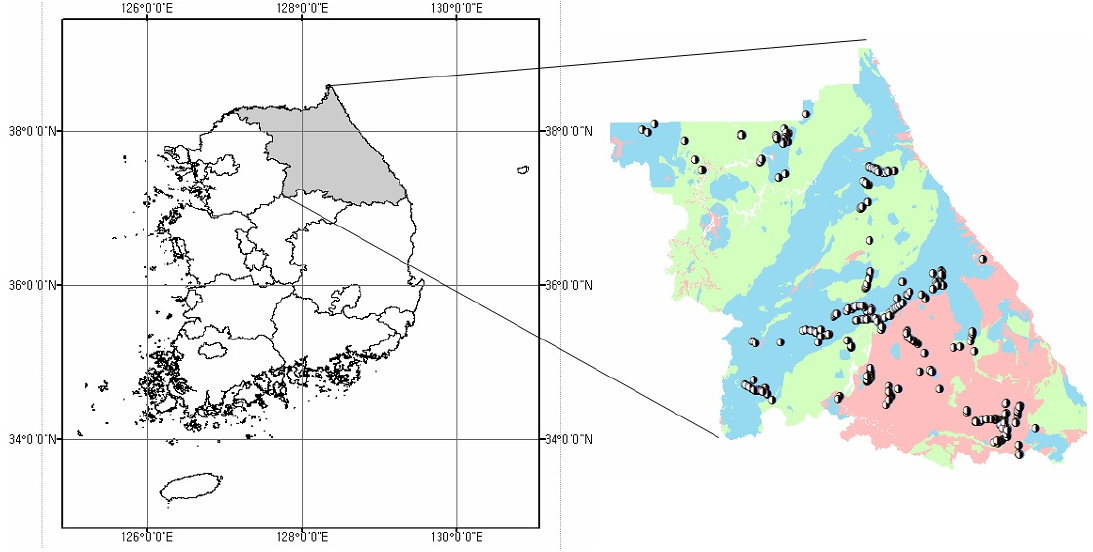
Figure 1. Location of study area and distribution of soil depth sampling Figure 1 . Location of study area and distribution of soil depth sampling sites.